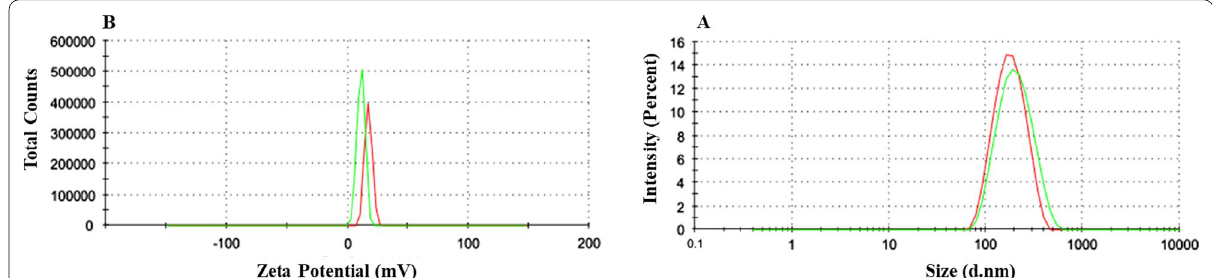
Fig. 1 a Particle size distribution of blank (red, average diameter 193 nm) and BSA nanoparticles (green, average diameter 200–300 nm) and b zeta potentials of blank (red) and BSA-loaded nanoparticles (green)